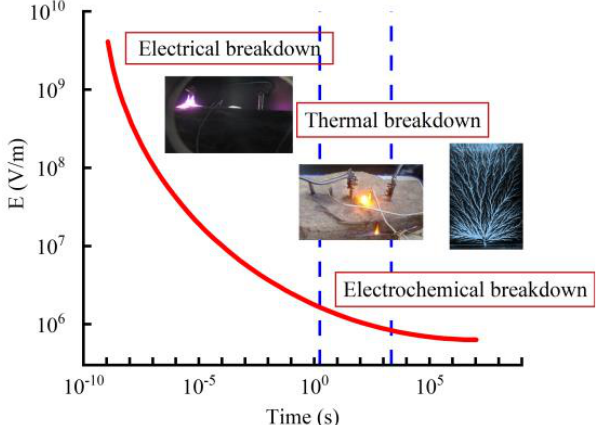
Figure 2. Relationship between the electric field intensity and the action time related to the break- down types.